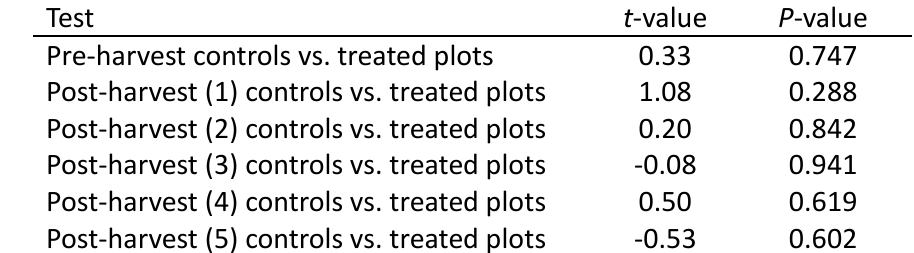
Table A1.3 . Year-specific treatment effects on density of Yellow-bellied Sapsucker, according to multiple comparison analyses (DF = 40).